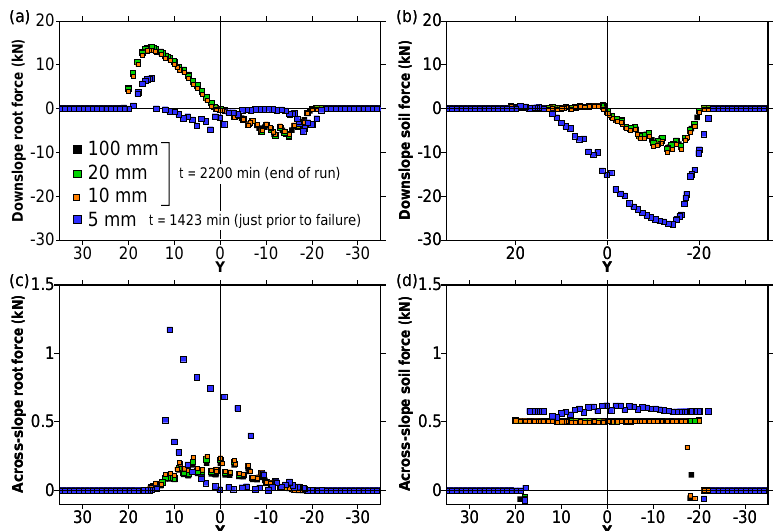
Figure 19. Effect of maximum root diameter on (a) downslope root force, (b) downslope soil force, (c) across-slope root force, and (d) across-slope soil force at the center line for the times specified in panel (a) .